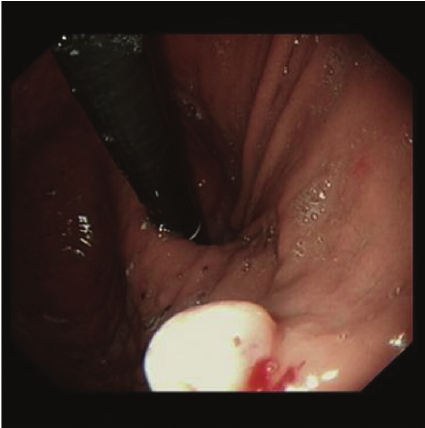
Figure 1: Oesophagogastroduodenoscopy (OGD) showing a gas- tric nodule.